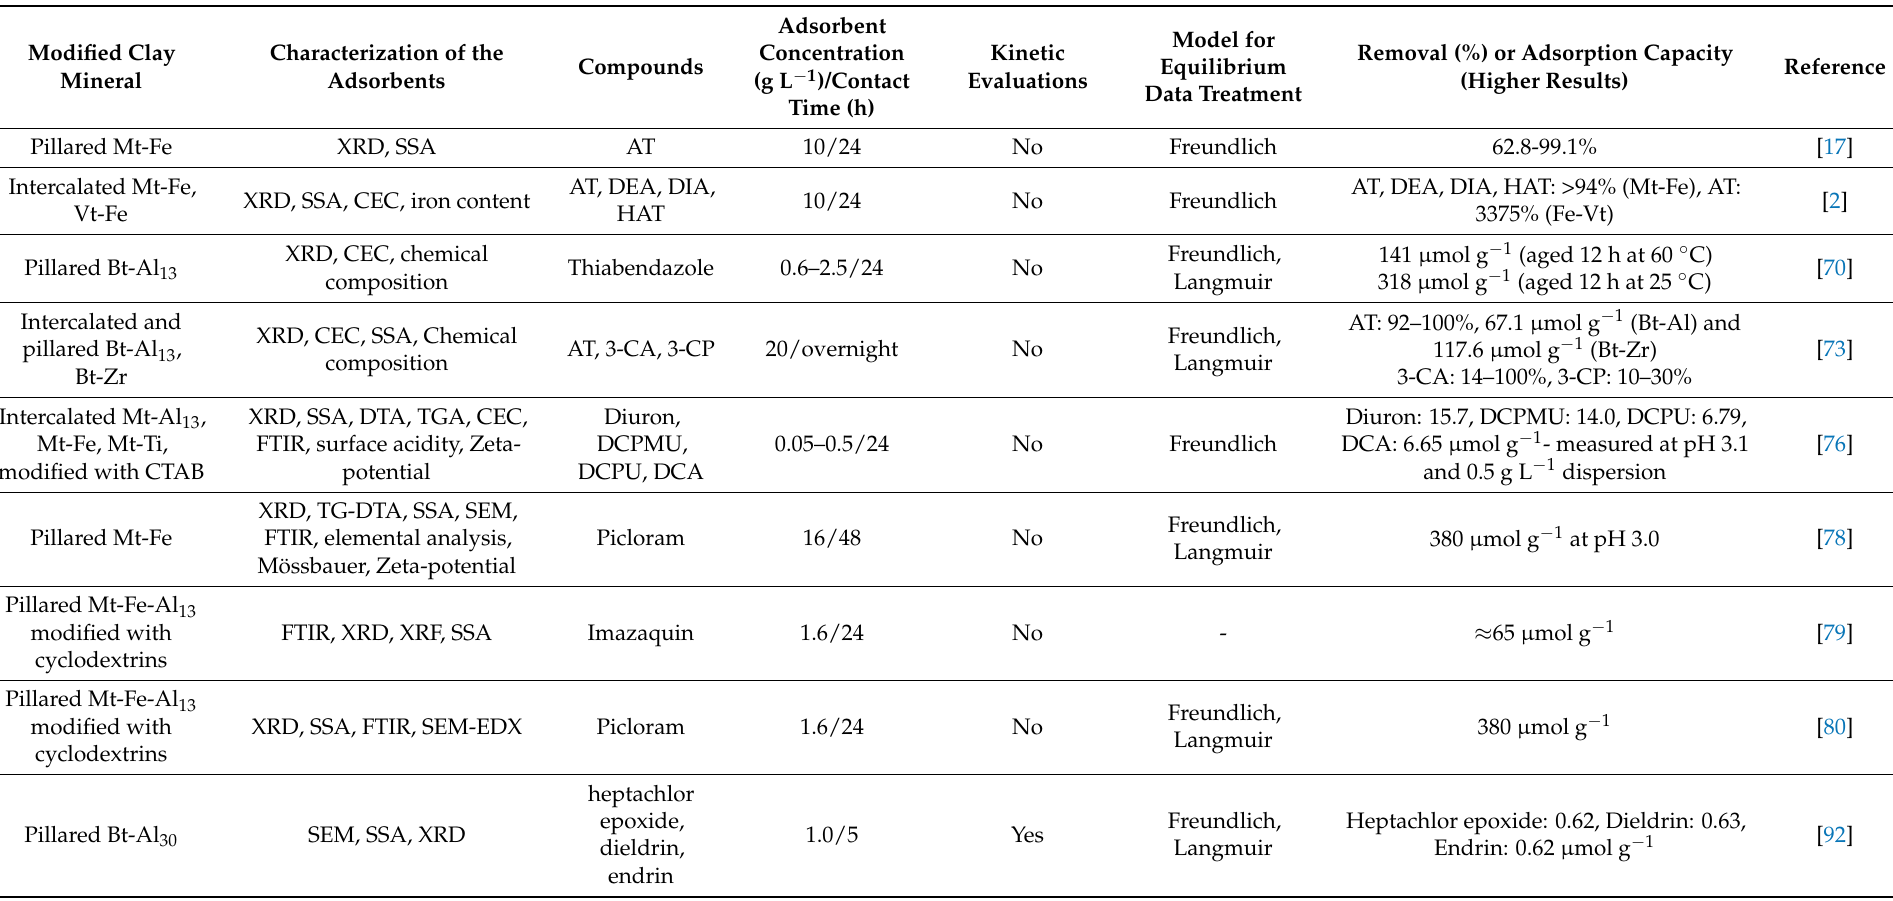
Table 5. Sorbent characterizations and sorption features of pesticides and metabolites onto intercalated or pillared clay